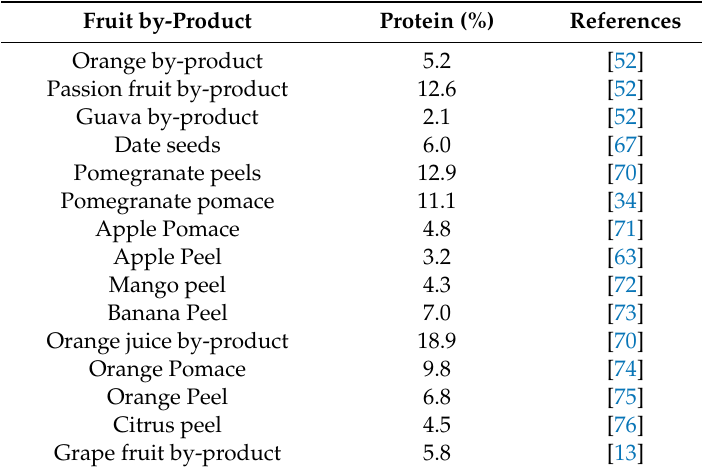
Table 3. Protein content in some fruit